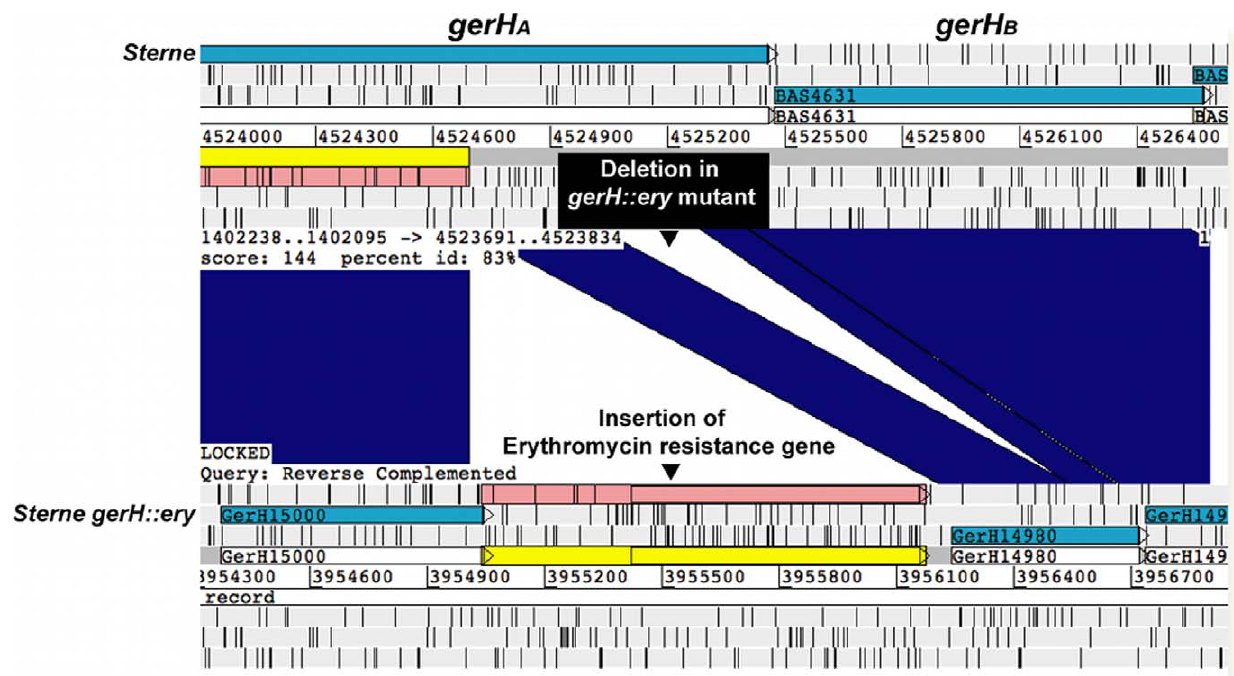
Figure 2. Alignment of gerH region between 34F2 and gerH::ery mutant. Screenshot of the gerH region of B. anthracis strains 34F2 and gerH::ery mutant by Artemis comparison tool (ACT)-based genome comparison. Blue bars indicate regions sharing significant matches using the BLAST alignment tool. The genome viewer tool shows the insertion of the erythromycin gene in the gerH A gene and a small deletion within gerH A gene downstream of the insertion.